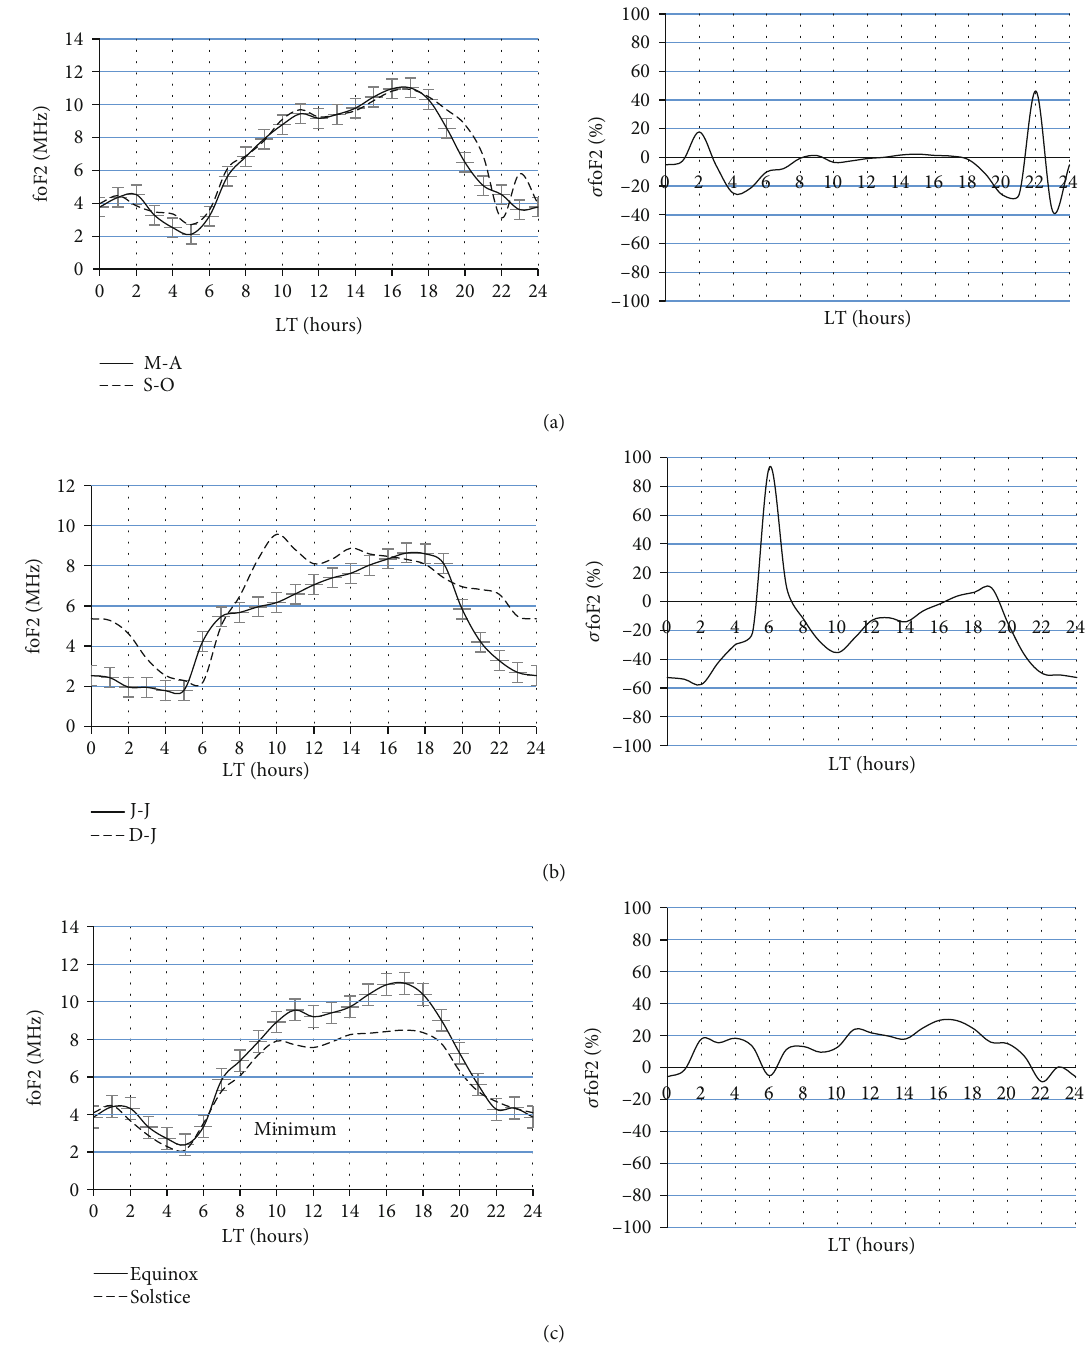
Figure 1: foF2 and σ foF2 diurnal variation for the minimum phase. (a) Concerns the equinox0 months, (b) for solstice months, and (c) for the comparison between equinox time and solstice months. The left columns are devoted for the foF2 diurnal pro fi les and the right one for the relative deviation percentage of the foF2 values ( σ